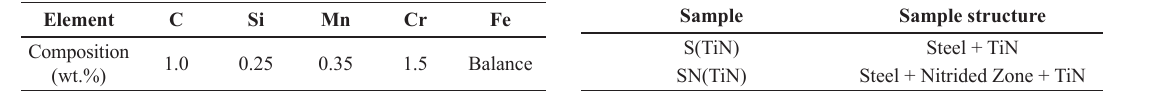
Table 1. Nominal chemical composition of the 100Cr6 steel used in the present investigation. Element C Composition (wt.%)